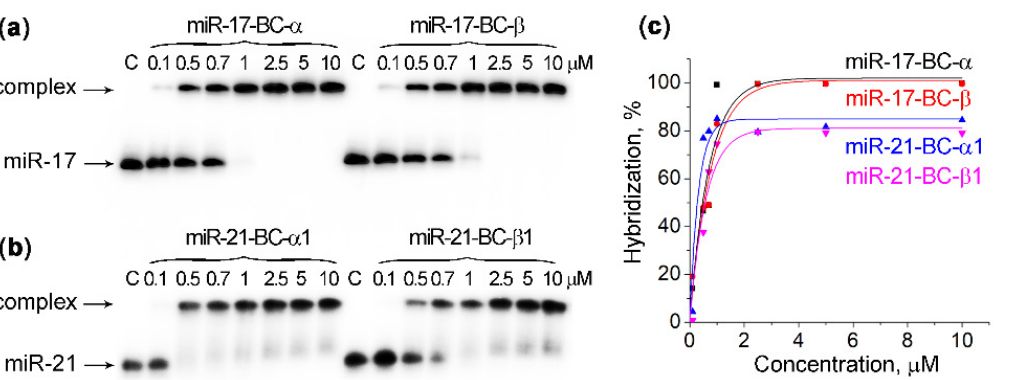
Figure 2. Hybridization of 5 (cid:48) -[ 32 P]-miRNAs with BCs in Buffer 1. ( a , b ) Radioautographs of 15% native PAAG, showing hybridization of miR-17–BC- α and miR-17–BC- β with miR-17 and miR-21– BC- α 1 and miR-21–BC- β 1 with miR-21, respectively. miRNAs (1 µ M) were incubated with BCs (0.1–10 µ M) in Buffer 1 (50 mM Tris–HCl, pH 7.0, 200 mM KCl, and 1 mM EDTA) at 37 ◦ C for 45 min. C: control, miRNA was incubated in the absence of conjugates. The samples were loaded onto the running gel immediately after the reaction was quenched, with 1 min intervals. The concentration ( µ M) of the conjugate is indicated on the top of electropherograms. ( c ) Concentration profiles of BC hybridization efficiency with miR-17 and miR ‐ 21.